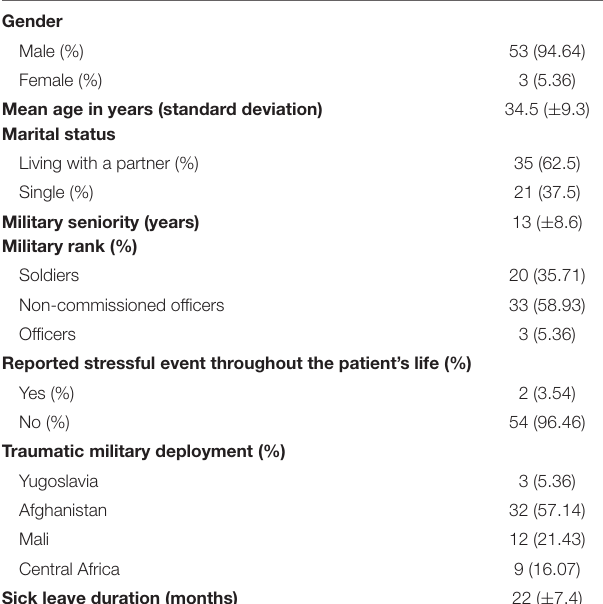
TABLE 1 | Sociodemographic characteristics of the